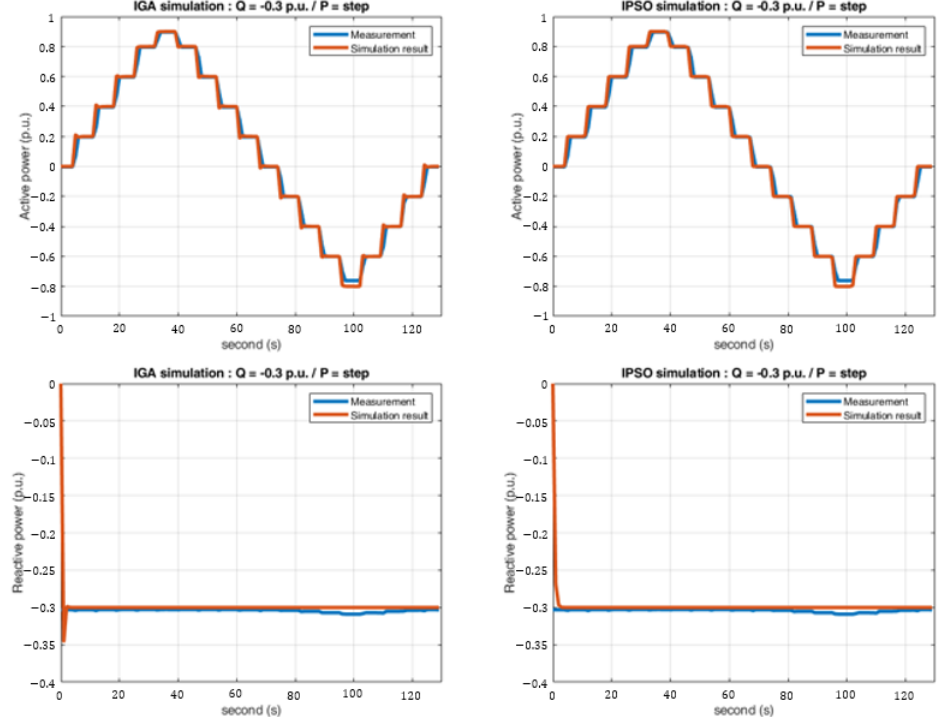
Figure 21. The IGA ( left ) and IPSO ( right ) fitting results .